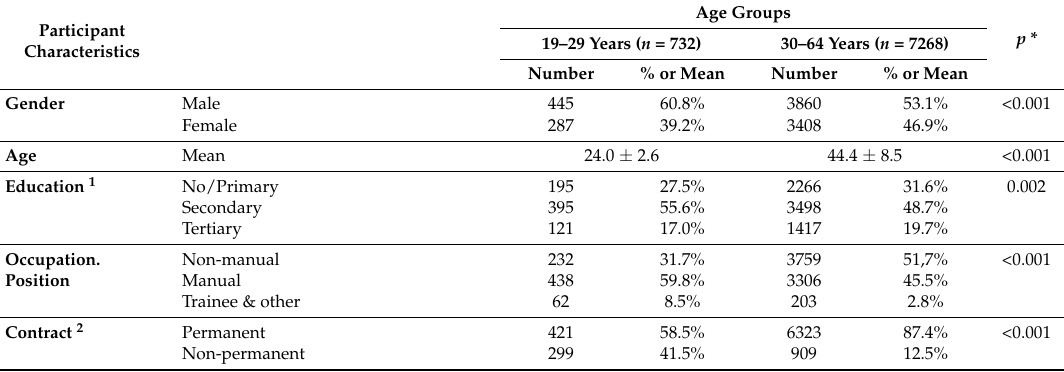
Table 1. Description of the analytical sample and main study variables ( n = 8000; INSuLa 1 survey 2014; numbers and column percentage (%) or mean ± standard